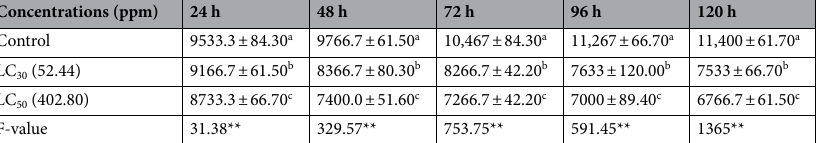
Concentrations (ppm) 24